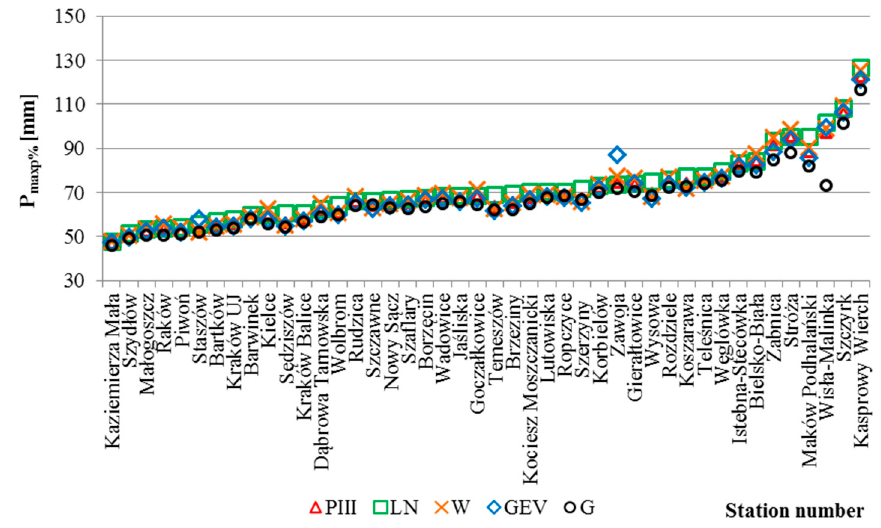
Figure 5. Values of P max 10% determined for the rainfall stations using the analyzed statistical distributions.